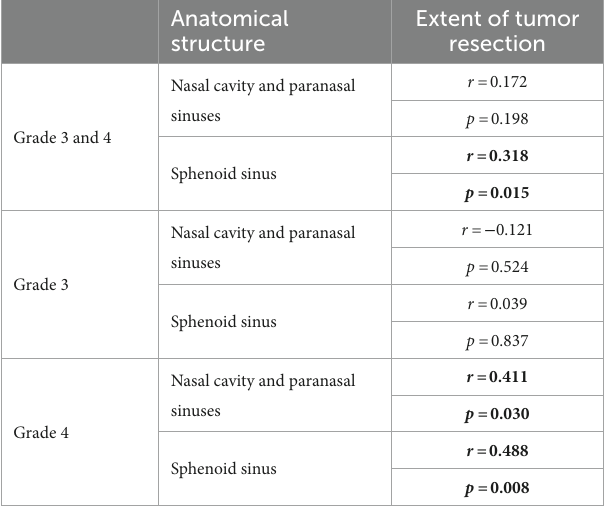
TABLE 4 Pearson’s correlation coefficient for the extent of tumor resection. Anatomical